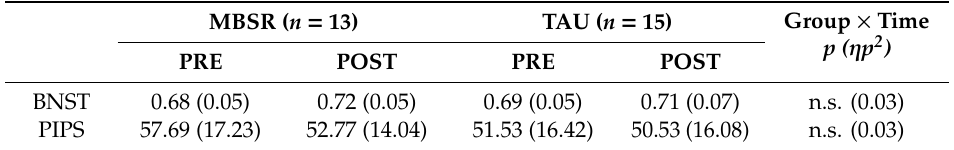
Table 3. Pre-post change in BNST volumes and PIPS scores following Mindfulness-Based Stress Reduction (MBSR) compared to Treatment-As-Usual (TAU) during